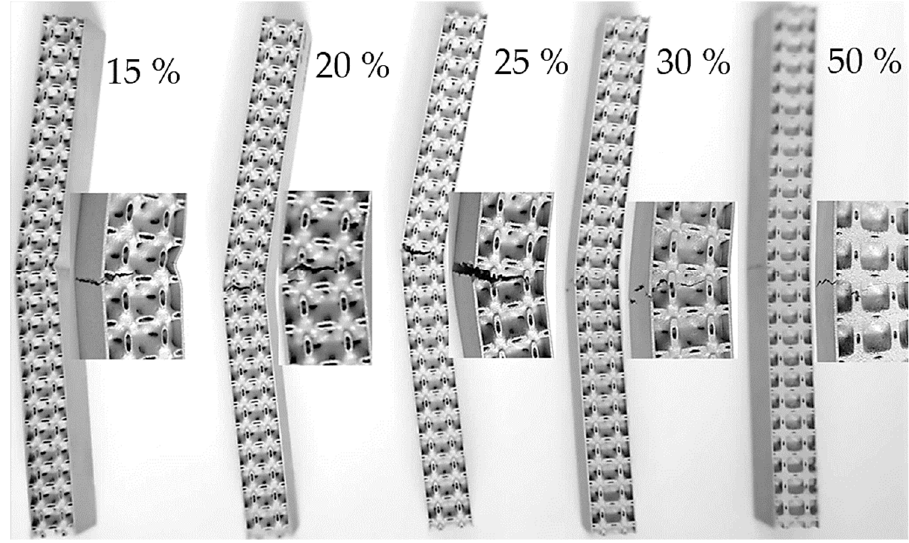
Figure 13. Visualization of cracks at individual specimens.